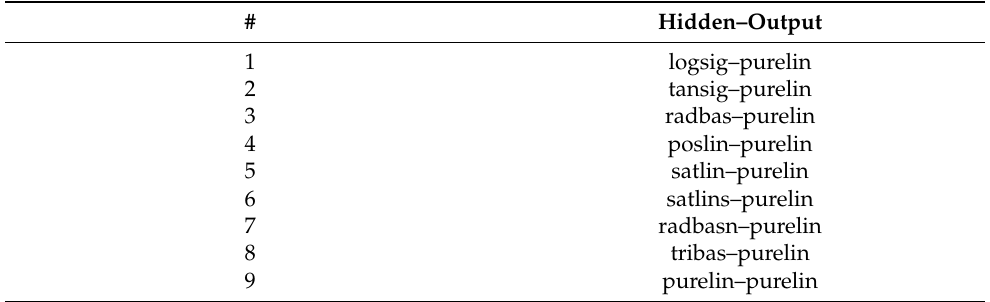
Table 1. Different tested combinations of transfer functions (TFs) for the hidden and output layers.